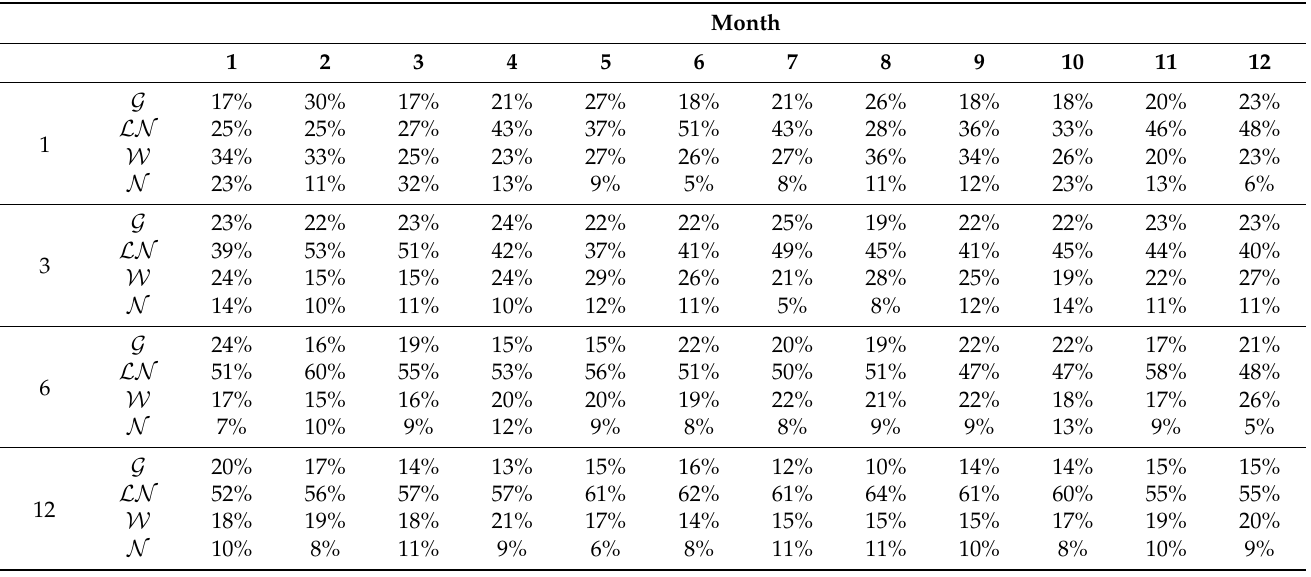
Table 4. Percentage of stations where the four tested distributions are selected as best fit model, for each k − th time scale and each j − th